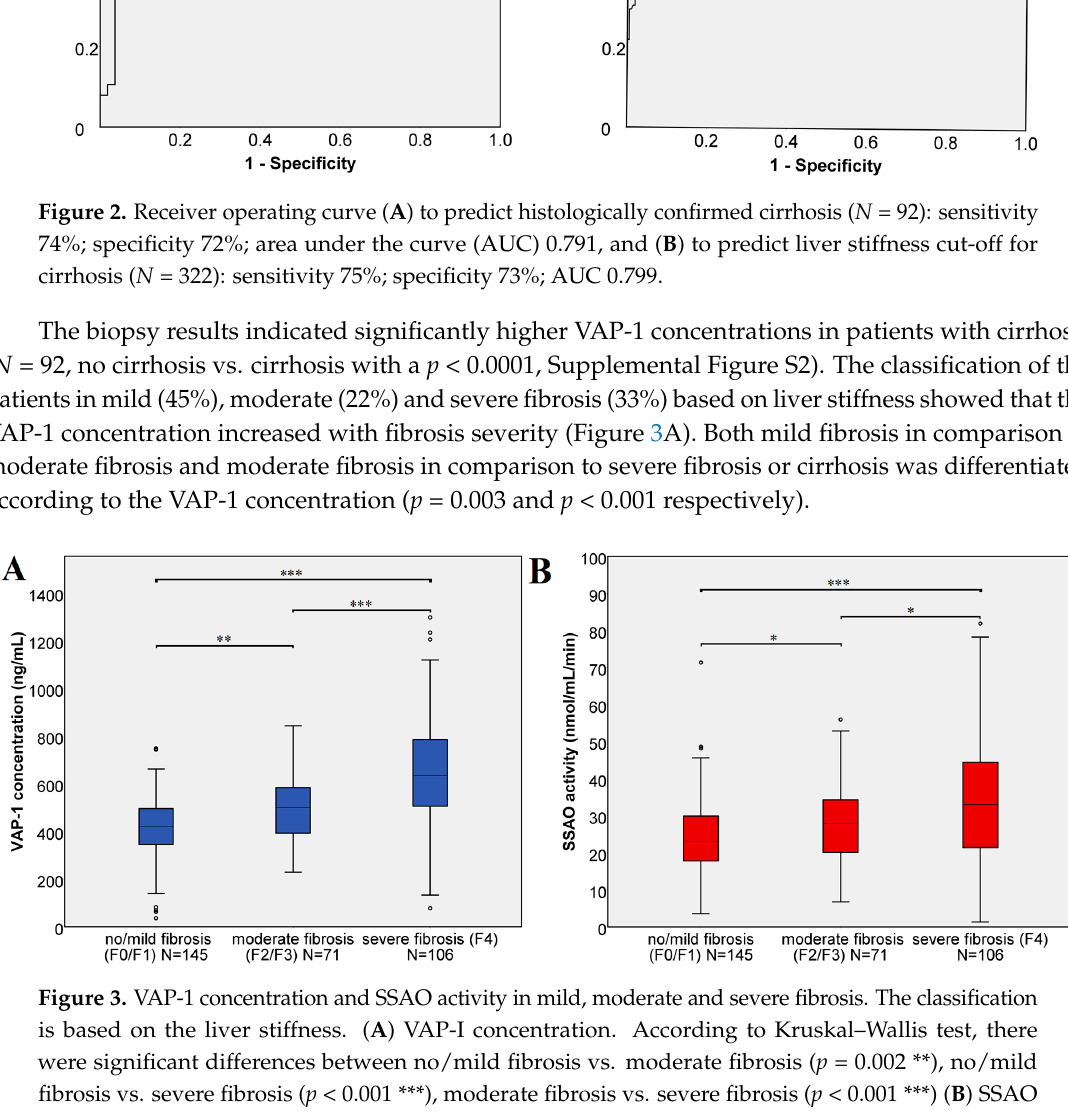
Figure 3. VAP-1 concentration and SSAO activity in mild, moderate and severe fibrosis. The classification is based on the liver stiffness. ( A ) VAP-I concentration. According to Kruskal–Wallis test, there were significant differences between no/mild fibrosis vs. moderate fibrosis ( p = 0.002 **), no/mild fibrosis vs. severe fibrosis ( p < 0.001 ***), moderate fibrosis vs. severe fibrosis ( p < 0.001 ***) ( B ) SSAO activity. According to Kruskal–Wallis test, there were significant differences between no/mild fibrosis vs. moderate fibrosis ( p = 0.023 *), no/mild fibrosis vs. severe fibrosis ( p < 0.001 ***), moderate fibrosis vs. severe fibrosis ( p = 0.028 *).